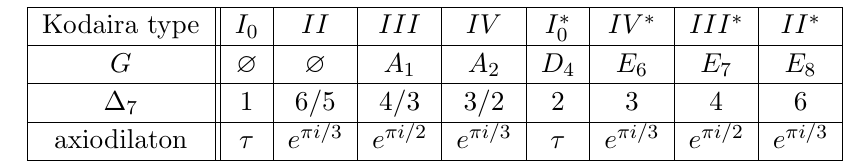
Table 2. Basic properties of F-theory 7-branes. I 0 corresponds to the absence of the 7-brane. Only in the I 0 and I (cid:3) cases the axiodilaton (i.e. the 4d gauge coupling) is not frozen to a speci(cid:12)c 0